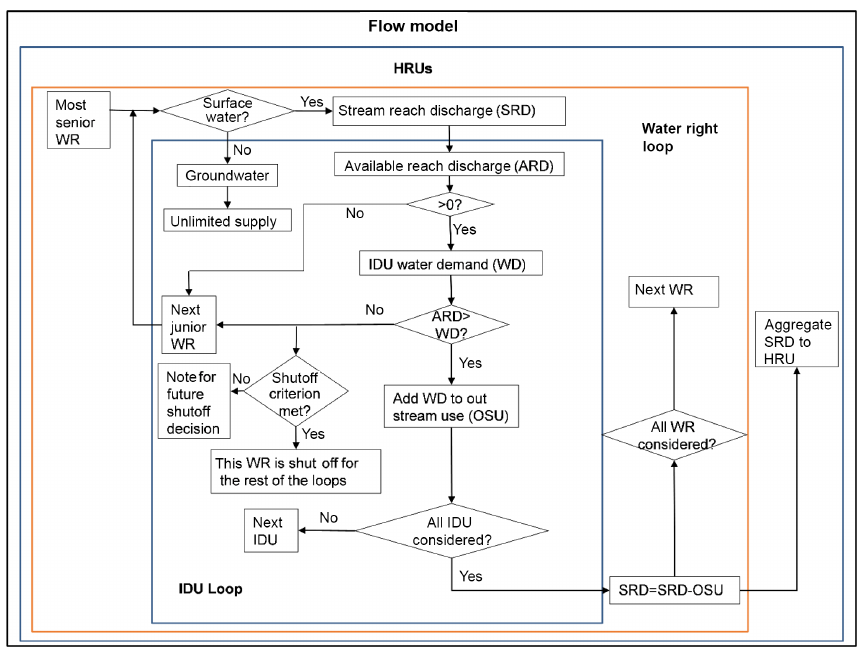
Figure 3. WaterMaster loop that makes use of the local water rights data for irrigation.